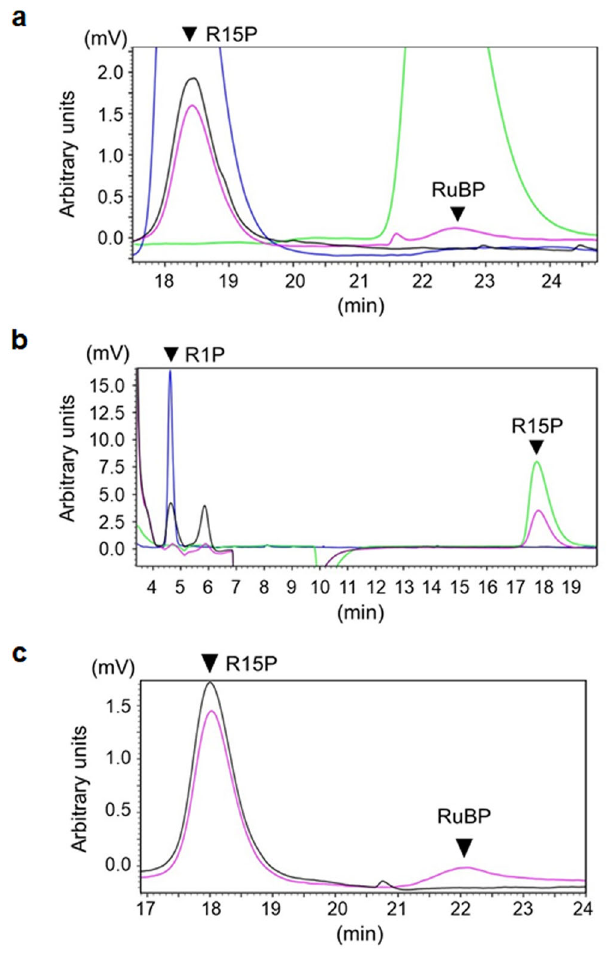
Fig. 2 Enzyme activity analyses of Ht -R15P isomerase and Hx -RbsK proteins with HPLC. a In the presence or absence of Ht -R15P isomerase enzyme, the generation of RuBP from R15P was investigated. Black, pink, blue, and green lines indicate the reaction product without the enzyme, that with the enzyme, 20 mM R15P standard compound, and 10 mM RuBP standard compound, respectively. b In the presence or absence of the Hx - RbsK protein, the generation of R15P from R1P was examined. Black, pink, blue, and green lines indicate the reaction product without the enzyme, that with the enzyme, 10 mM R1P standard compound, and 20 mM R15P standard compound, respectively. c Conversion of R1P with the Hx -RbsK and Ht -R15P isomerase proteins was examined. After the kinase reaction by Hx -RbsK, the isomerase reaction by Ht -R15P isomerase was carried out. The reaction product was analyzed by HPLC. Pink and black lines indicate reaction products with and without Ht -R15P isomerase in the second reaction, respectively. Compounds separated with a column were monitored with a differential refractive index